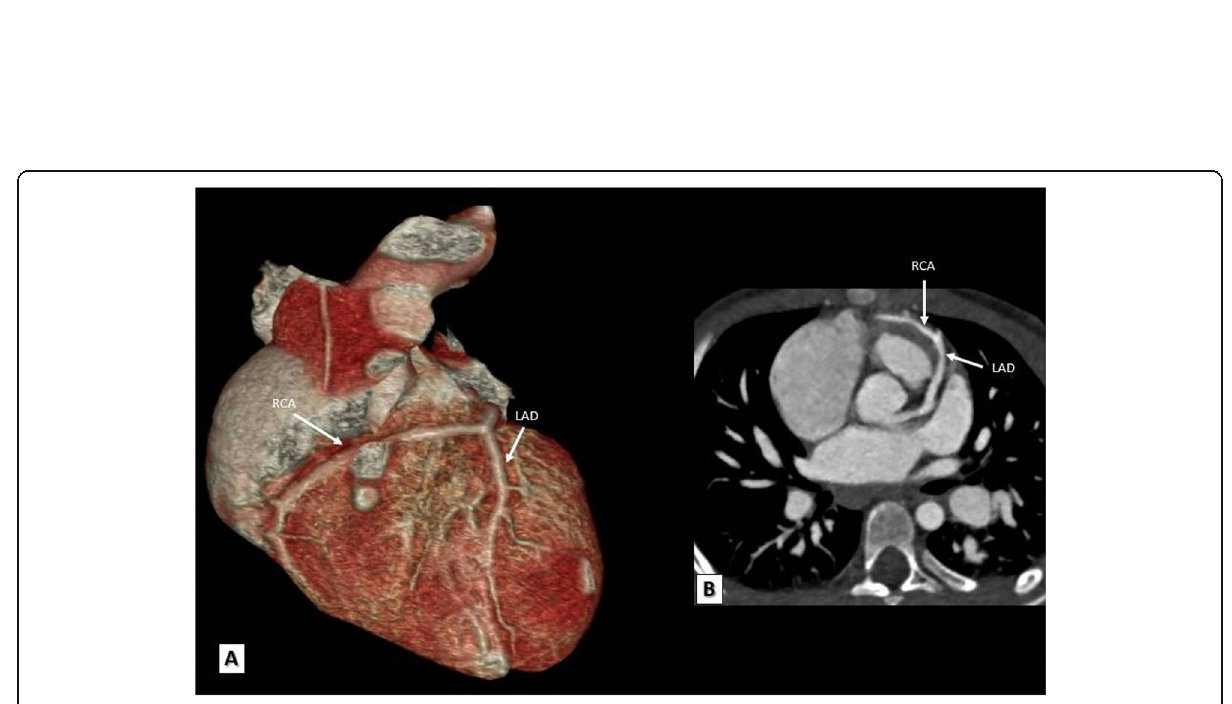
Fig. 5 a , b A TOF patient. a 3D VRT and b reformatted MDCT axial images showing the right coronary artery arising from the left anterior descending artery and crossing the RVOT anteriorly to reach the right atrio-ventricular groove. LAD, left anterior descending; RCA, right coronary artery